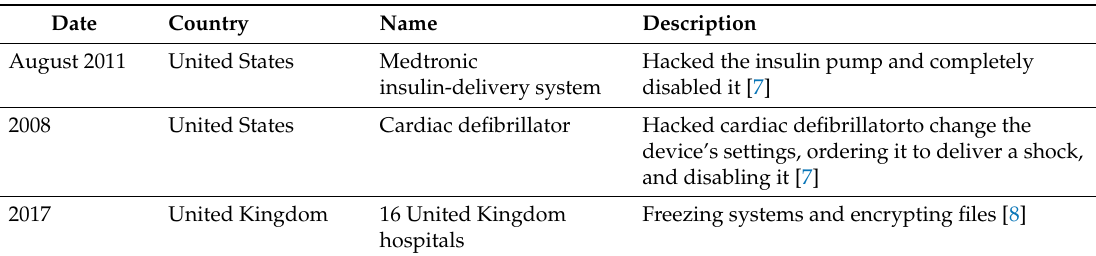
Table 1. Cyberattack incidents in the medical